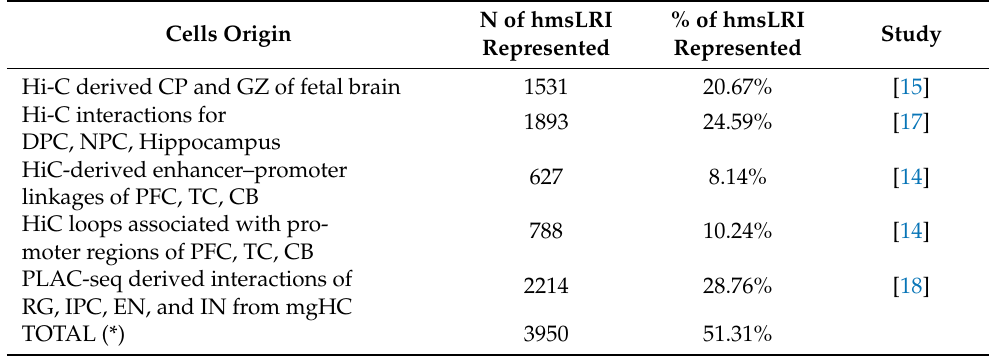
Table 2. Human putative interactions in this study (hmsLRI) that are found within experimentally determined human interactions datasets in neural cells . The numbers of hmsLRI represented within the indicated datasets of interactions are indicated, together with the percentage of total hmsLRI (7698, Table 1) represented by these numbers. (*) interactions represented within more than one study were counted only once. CP, cortical plates; GZ, germinal zone; DPC, dorsolateral prefrontal cortex; NPC, neural progenitor cells; PFC, prefrontal cortex; TC, temporal cortex; CB, cerebellum; RG, radial glia; IPC, intermediate progenitor cell; EN, excitatory neurons; IN, interneurons; mgHC, mid-gestational human cortex. N of hmsLRI % of hmsLRI Cells Origin Study Represented Represented Hi-C derived CP and GZ of fetal brain 1531